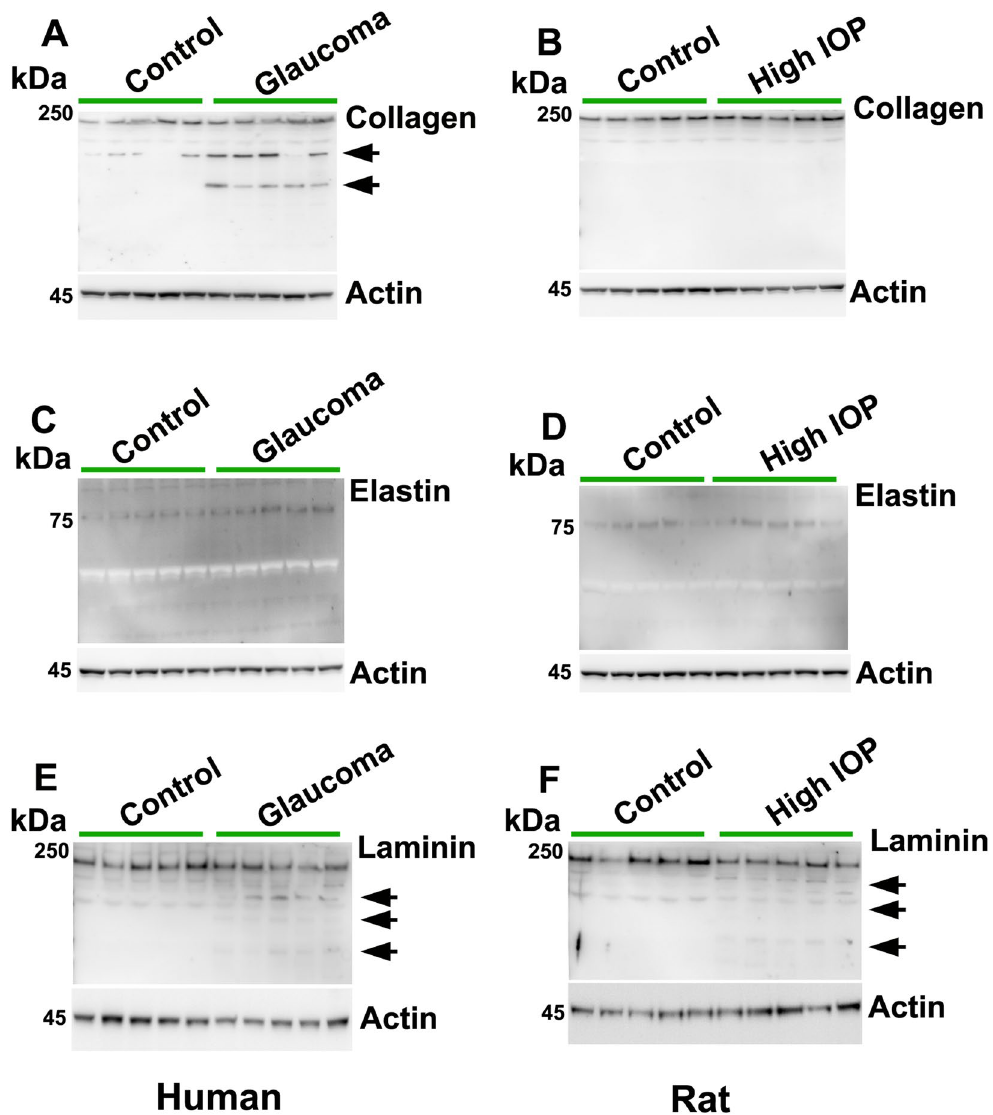
Figure 10. Control and glaucomatous human (n = 10) and rat retinal tissue lysates (n = 5) were immunoblotted and probed for ( A,B ) collagen (C,D ) Elastin and ( E,F ) laminin immunoreactivity. Arrows indicate degradation products of the ECM proteins in the glaucomatous samples. Actin was used for protein normalisation in each